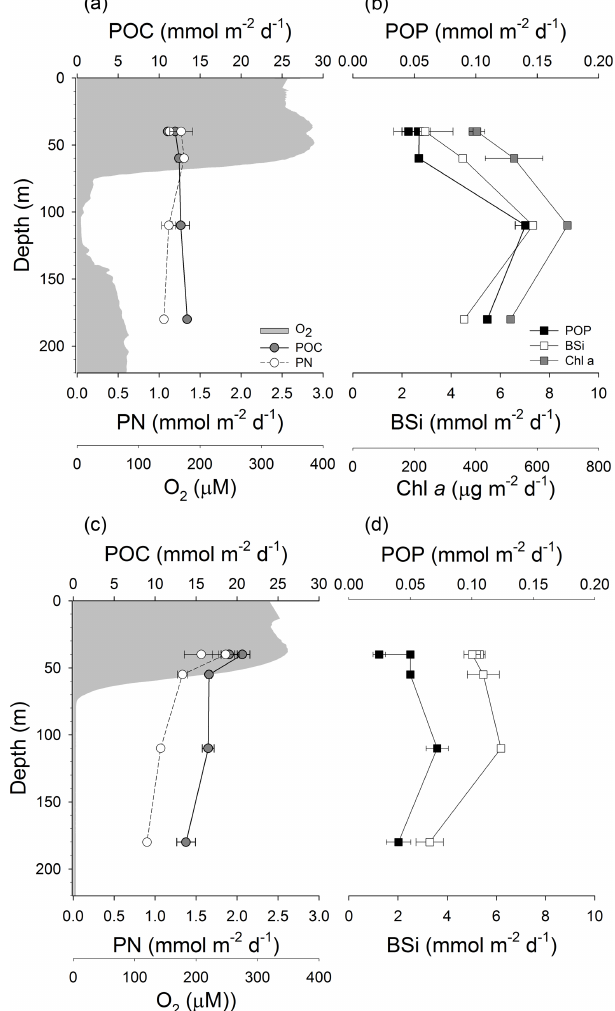
Figure 5. Vertical fluxes of particulate organic carbon (POC) and particulate nitrogen (PN) as well as oxygen concentration in GB (a) and LD (c) . Vertical fluxes of particulate organic phosphorus (POP), biogenic silica (BSi) and chlorophyll a (Chl a ) in GB (b) and LD (d)